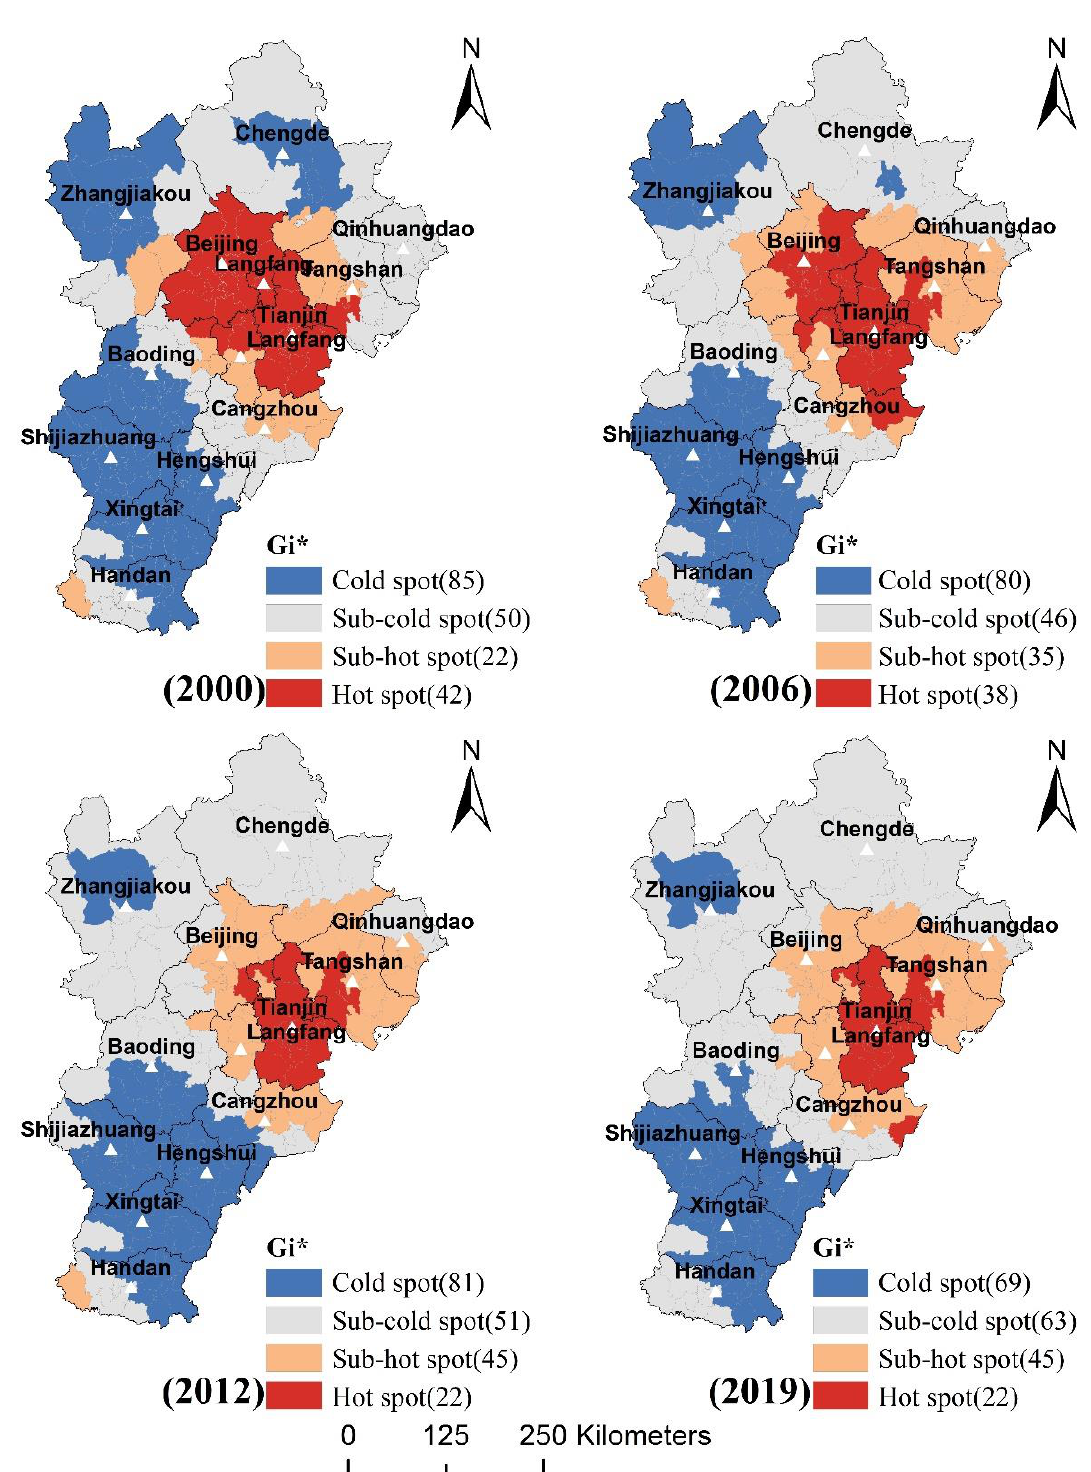
Figure 11. Aggregation of energy CO 2 emissions in Beijing-Tianjin-Hebei in 2000, 2006, 2012 and 2019.